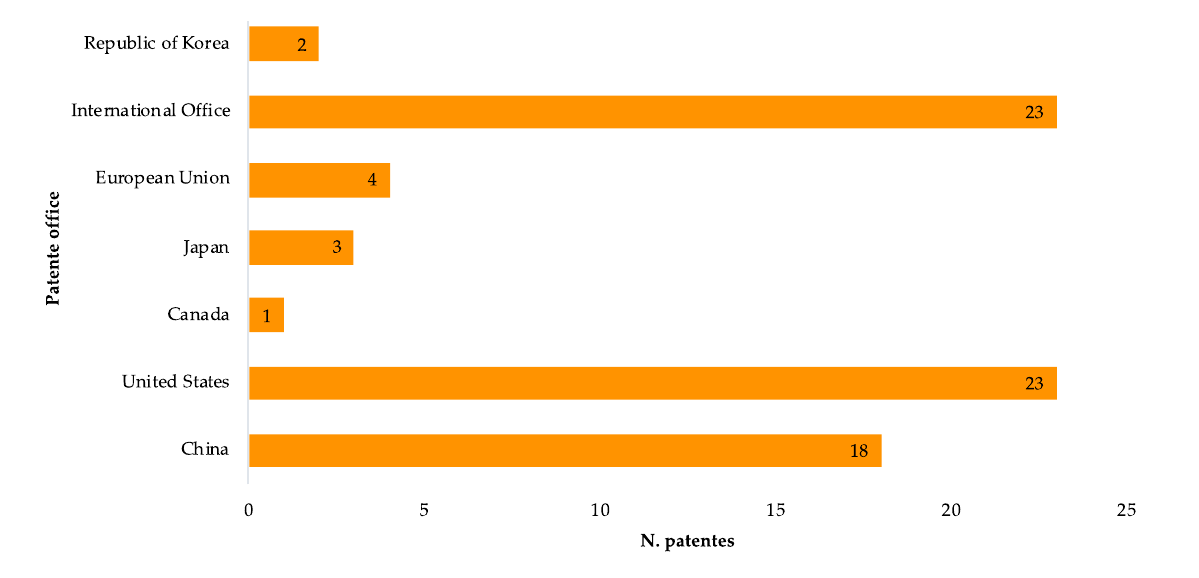
Figure 4. Patents by each patent office.